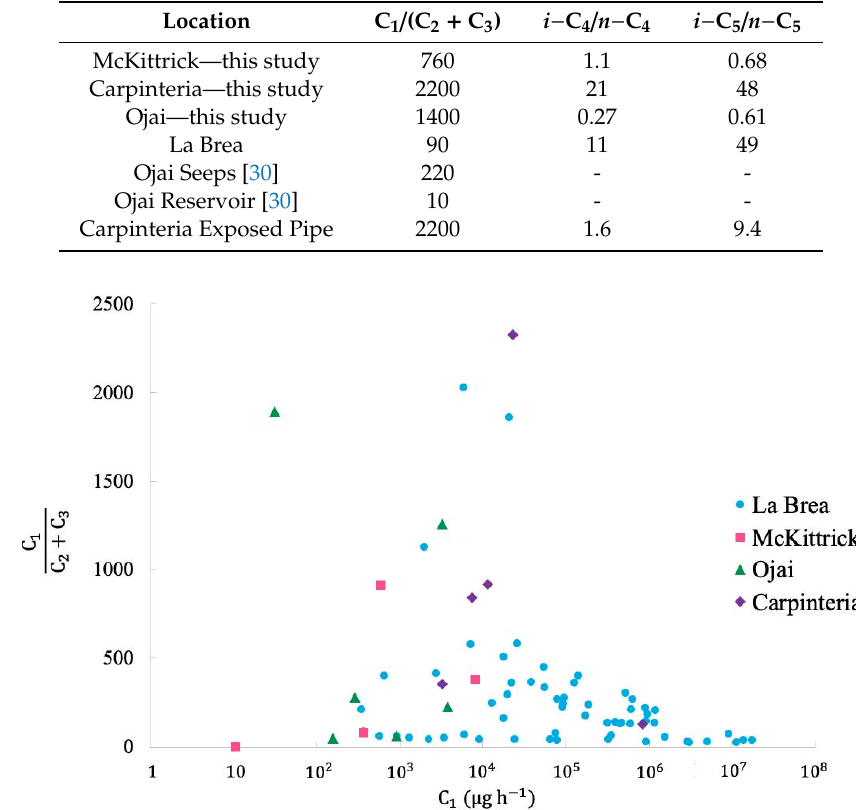
Table 3. Gas ratios by volume ( v / v ) observed by site in this and previous studies [30].